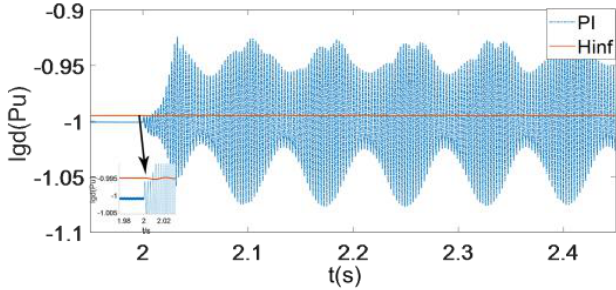
Figure 34. The influence of different voltage k p 2 on i gd.